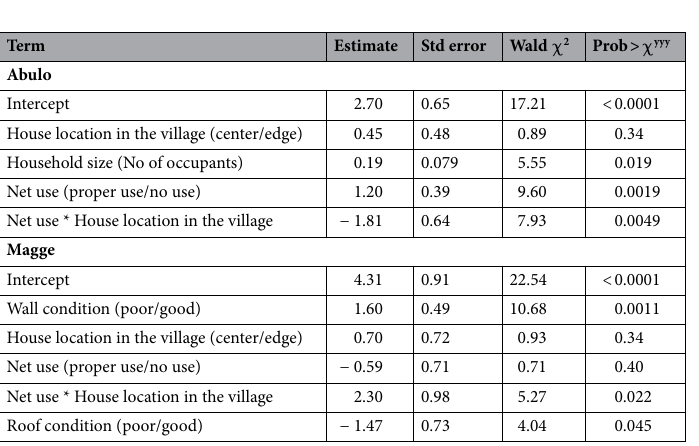
Figure 3. Map showing the number of infectious bites an individual receives per year (the red bars) and the households in the study areas (the grey dots). The scale bars indicate distance (m).